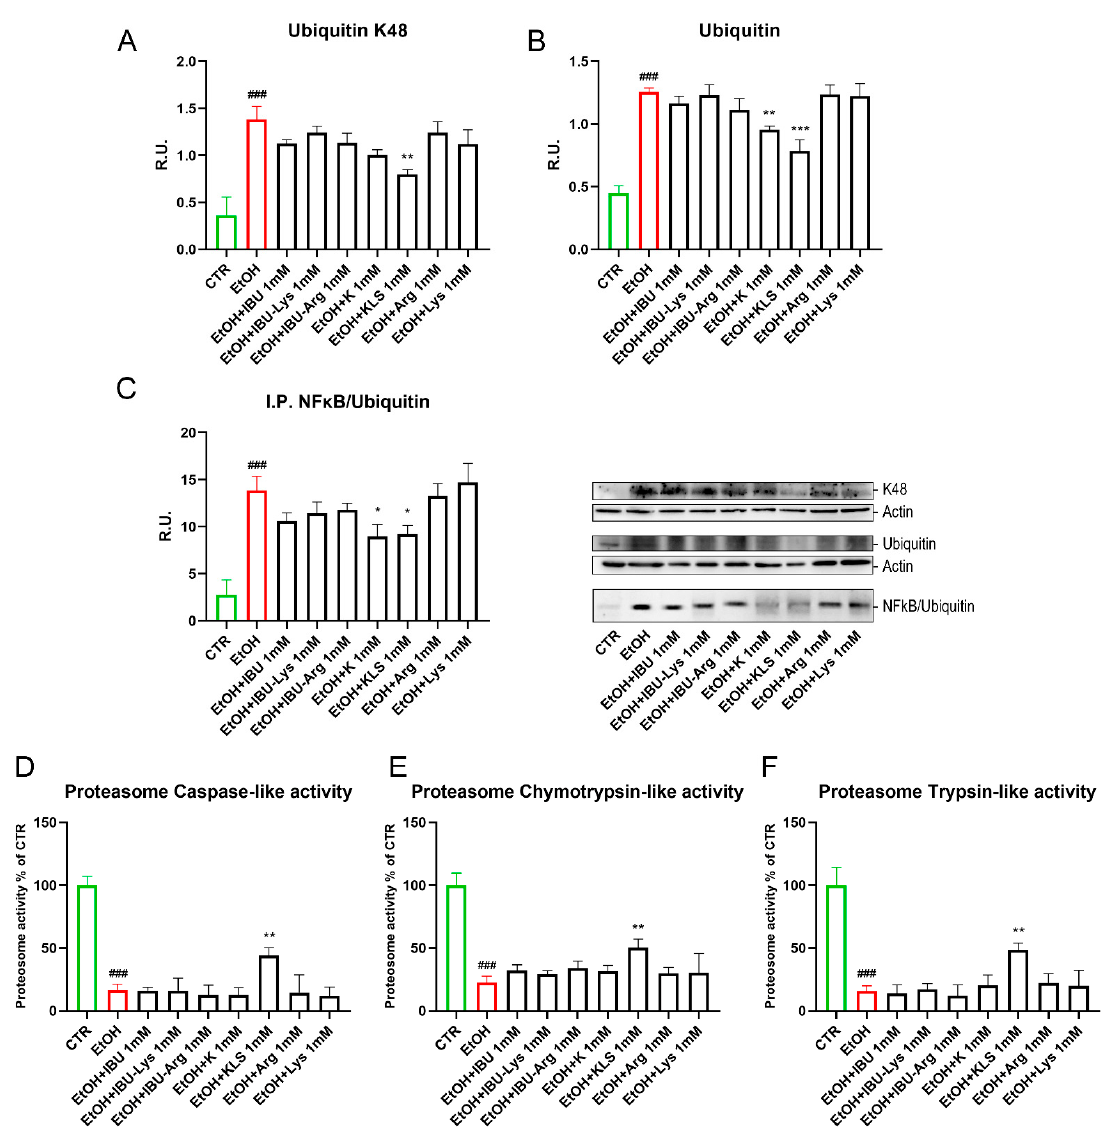
Figure 6. ( A ) WB analysis for ubiquitin K48 and ( B ) Ubiquitin on Caco-2 cells after EtOH challenge (6%, for 24 h), EtOH + IBU, EtOH + IBU-Lys, EtOH + IBU-Arg, EtOH + K, EtOH + KLS, EtOH + Arg, and EtOH + Lys treatments (1 mM for 72 h). ( C ) Immunoprecipitation for NF κ B on Caco-2 cells after EtOH challenge (6%, for 24 h), EtOH + IBU, EtOH + IBU-Lys, EtOH + IBU-Arg, EtOH + K, EtOH + KLS, EtOH + Arg, and EtOH + Lys treatments (1 mM for 72 h). Data are mean ± SD of 3 different experiments. The image blot is a representative one. ( D – F ) Proteasome activities on Caco-2 cells after EtOH and NSAID treatments. Data are mean ± SD of 3 different experiments. One way ANOVA was performed: ***, p < 0.0001; **, p < 0.005; *, p < 0.05 vs. EtOH; ###, p < 0.0001 EtOH vs. CTR.